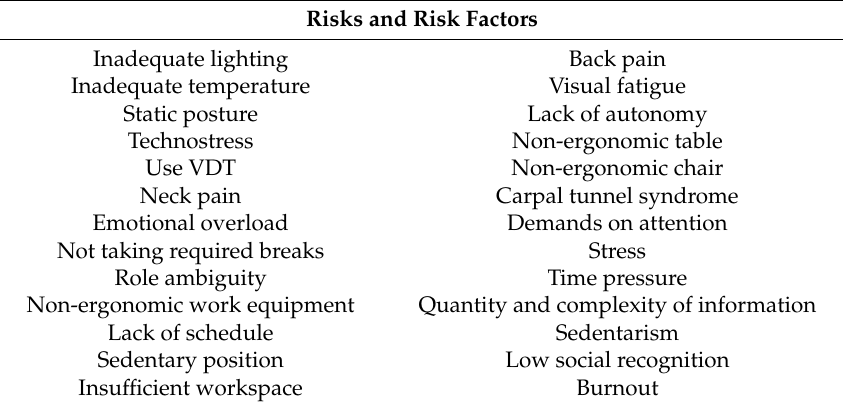
Table 4. Risk factors and risks according to expert